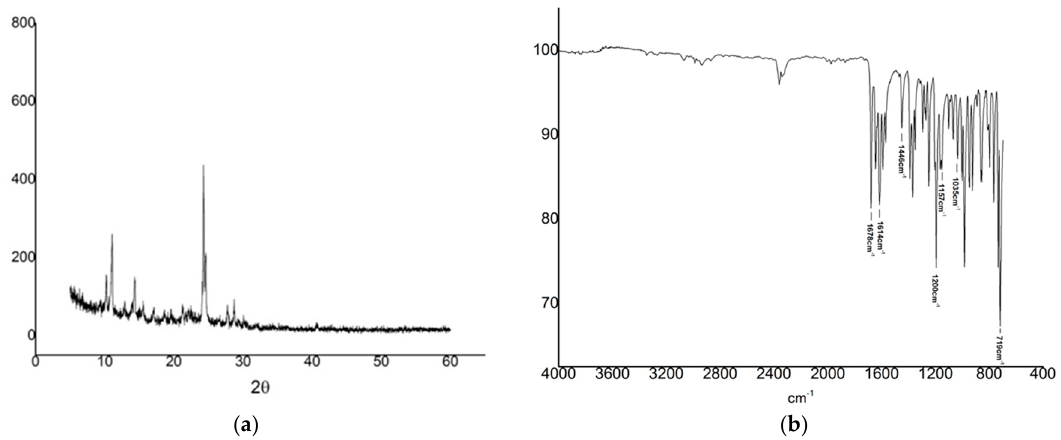
Figure 3. X-ray diffraction pattern ( a ) and Fourier-transform infrared (FT-IR) spectrum ( b ) of IVS320.